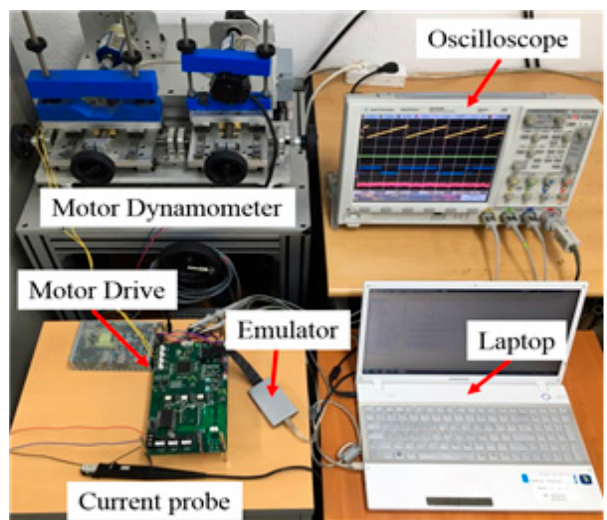
Figure 12. Experimental of SPMSM drive set up. Energies 2017 , 10 , 1160 12 of 16